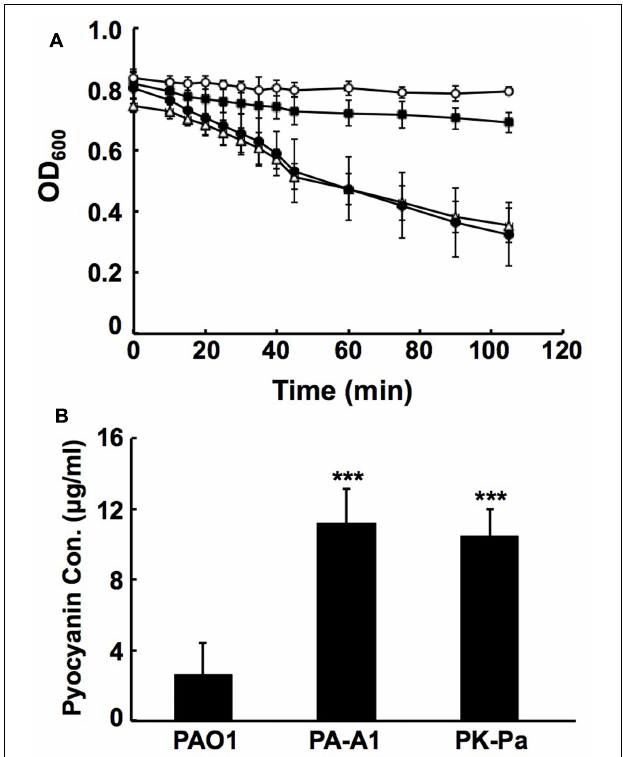
FIGURE 5 | Analysis of LasA activities and pyocyanin production in P. aeruginosa acpP1 mutant strains. (A) LasA protease activities in culture supernatants of P. aeruginosa strains. Empty circle indicates boiled Staphylococcus aureus cells; filled square indicates boiled S. aureus cells containing culture supernatants of P. aeruginosa mutant strain PA-A1; filled circle indicates boiled S. aureus cells containing culture supernatants of P. aeruginosa PAO1; empty triangle indicates boiled S. aureus cells containing culture supernatants of complementary strain PK-Pa. (B) Pyocyanin in culture supernatants of P. aeruginosa strains. Data are the mean ± standard deviation of triplicate measurements. Pair-wise comparisons were made between wild type strain PAO1 and mutant strain PA-A1 or complementary strain PK-Pa by Student’s t -test. ∗∗∗ Highly significant difference, P < 0.01.